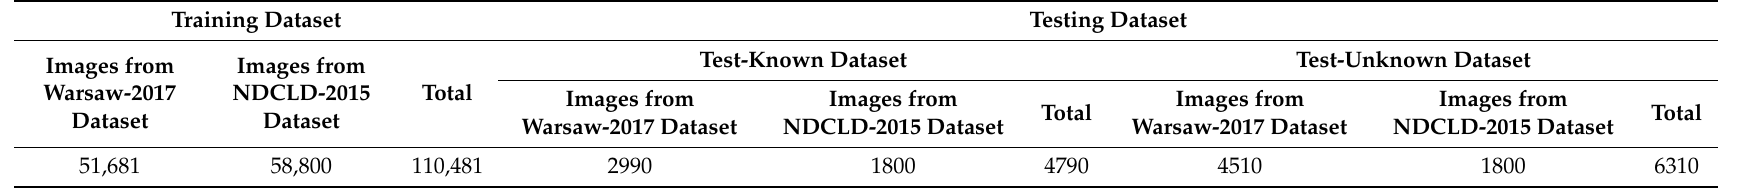
Table 11. Description of training and testing datasets of fusion of Warsaw-2017 and NDCLD-2015 datasets.